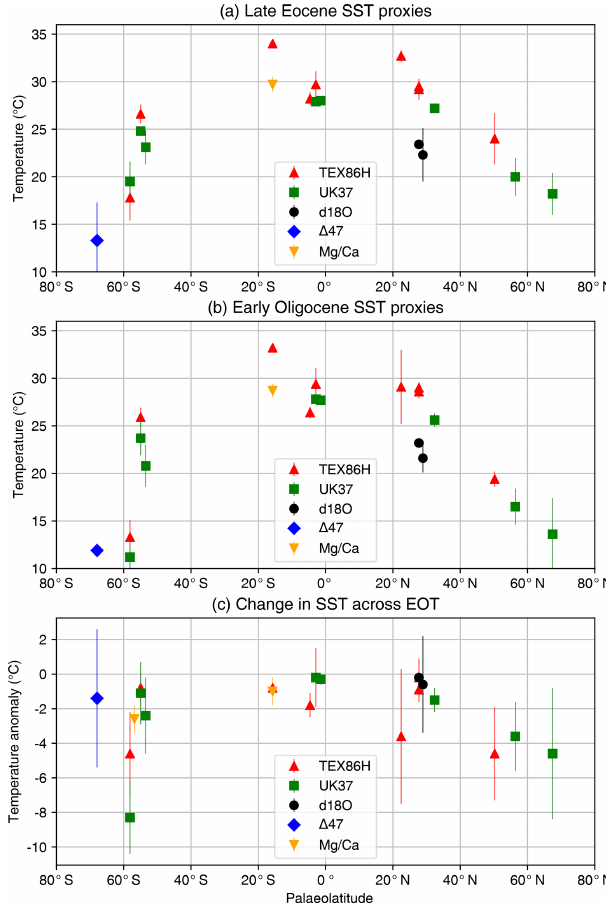
Figure 3. Summary of sea surface temperature (SST) change across (cid:48) the EOT from proxies TEX H , U K , δ 18 O, (cid:49) 47 , and Mg / Ca. (a) 86 37 Late Eocene, (b) early Oligocene and (c) change in SST across the EOT. Data shown in panels (a) and (b) are only from locations that record a temperature signal on both sides of the EOT. Data com- piled from Bohaty et al. (2012), Cramwinckel et al. (2018), Inglis et al. (2015), Kobashi et al, (2004), Lear et al. (2008), Liu et al. (2009, 2018), Pearson et al. (2007), Petersen and Schrag (2015), Piga (2020), ´Sliwi´nska et al. (2019), Wade et al. (2012) and Zhang et al. (2013). The late Eocene value was calculated as an average be- tween 38 and 33.9Ma (pre-EOT), while the early Oligocene value was calculated as the average between 33.9 and 30Ma (post-EOT), and the change across the EOT is the difference between these val- ues. The data compilation is provided in digital form in Table S1 in the